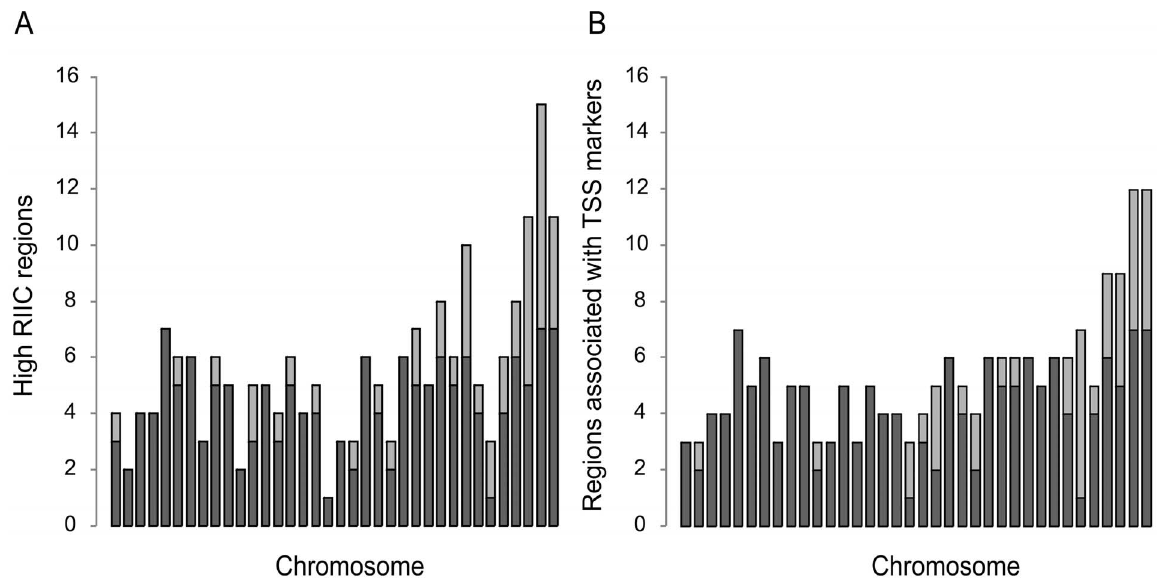
Figure 4. Comparative analysis of high RIIC regions vs. reported putative TSS for each L.major chromosome. A . The total number of high RIIC regions for each L. major chromosome, depicted in ascending order from left to right, is represented. Dark grey indicates high RIIC scoring regions that overlap with regions associated with TSS markers reported by Thomas et al. [18]. B . The total number of regions associated with TSS markers obtained in Thomas, et al . [18] for each L. major chromosome, depicted in ascending order from left to right, is represented. Dark grey indicates the number of regions associated with TSS markers that overlap high RIIC regions.